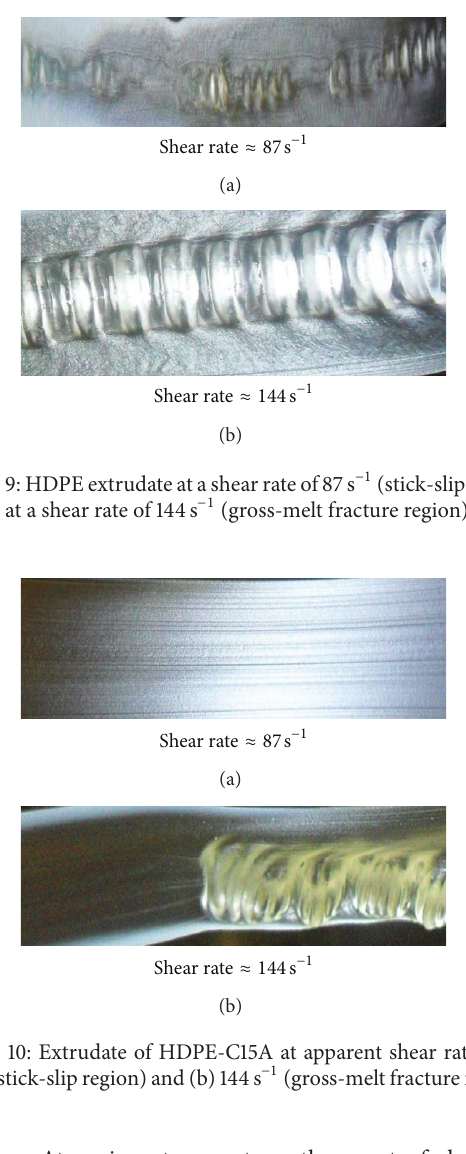
additives. At a given temperature, the onset of sharkskin depends on the composition and types of additive. For pure HDPE it was observed at 68 s −1 while the same onset shifted to a value between 87 and 144 s −1